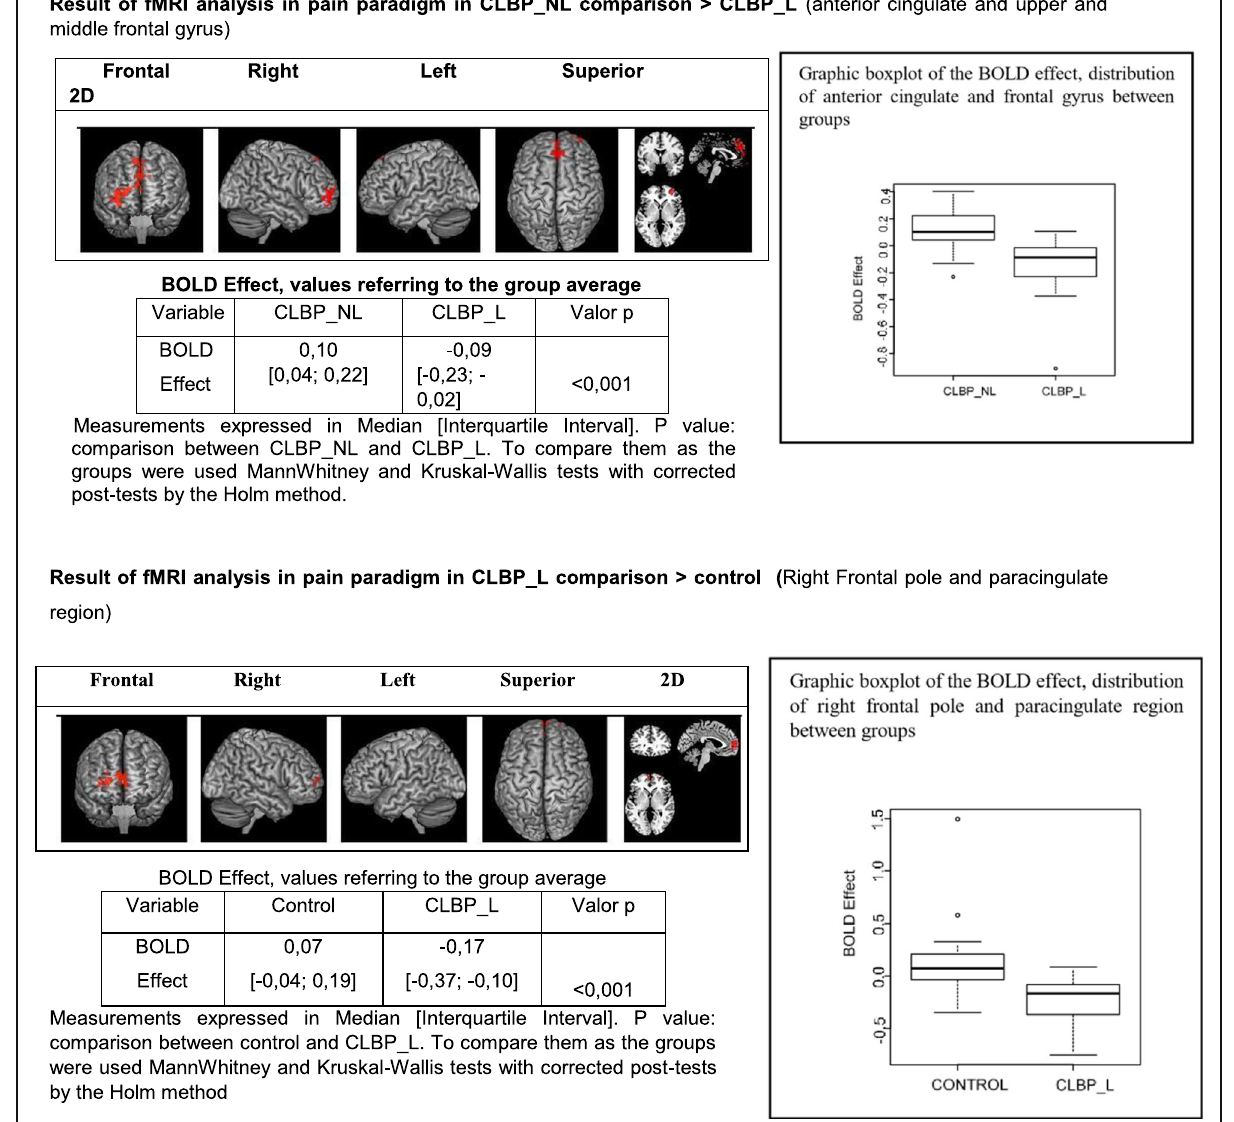
Fig. 2 3D image of brain containing result of fMRI covariate analysis considering the weight used in the pain